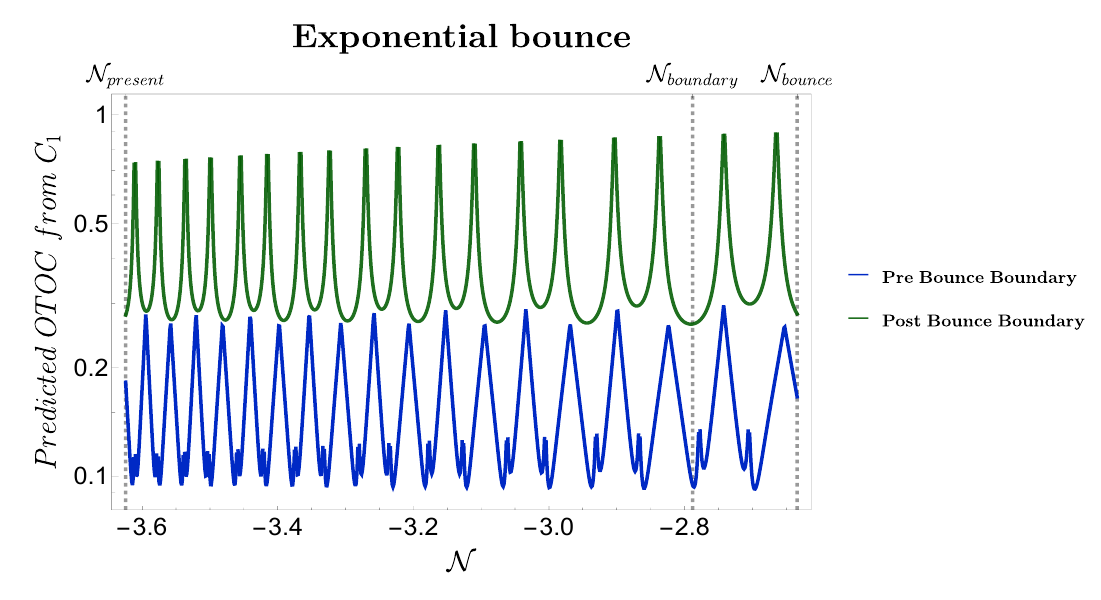
Figure 40: Predicted OTOC from linearly weighted complexity outside bouncing re- gion with respect to number of e-foldings.